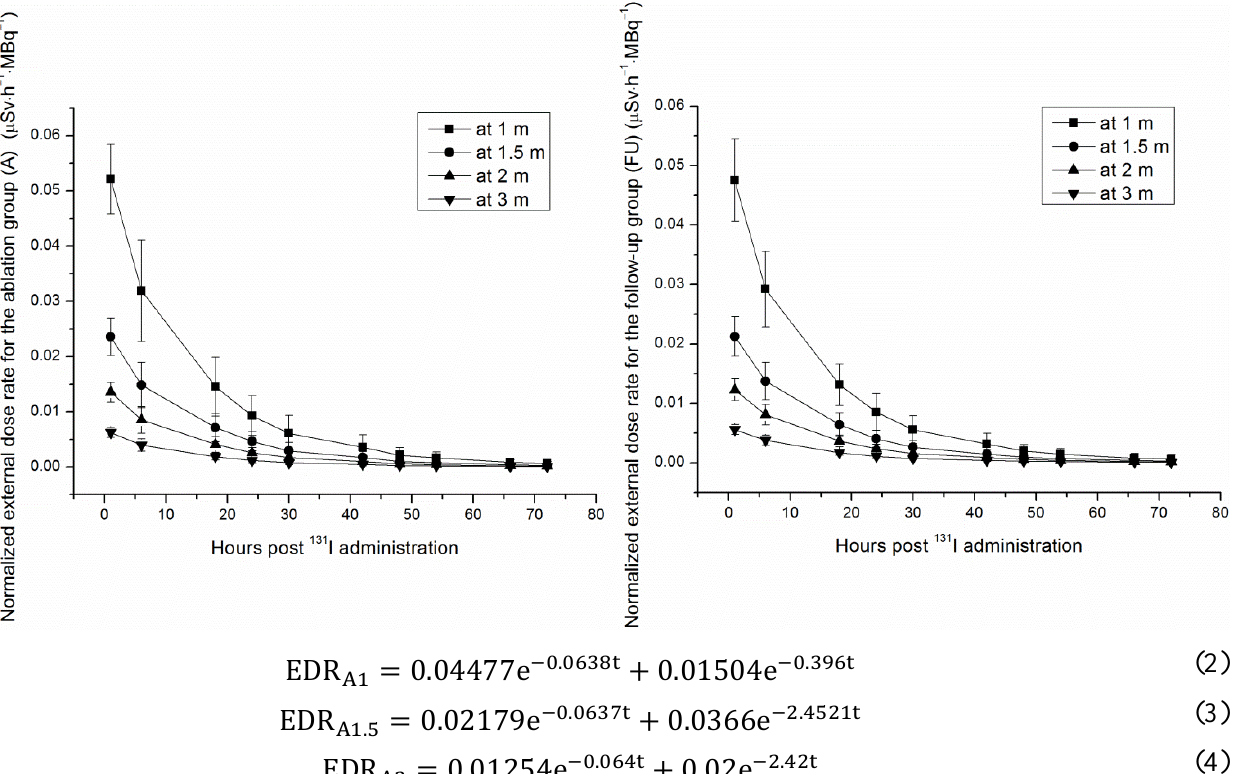
Figure 1. External dose rates at 1 m, 1.5 m, 2 m and 3 m plotted as a function of hours post 131 I administration for the ablation group (A) and the follow-up group